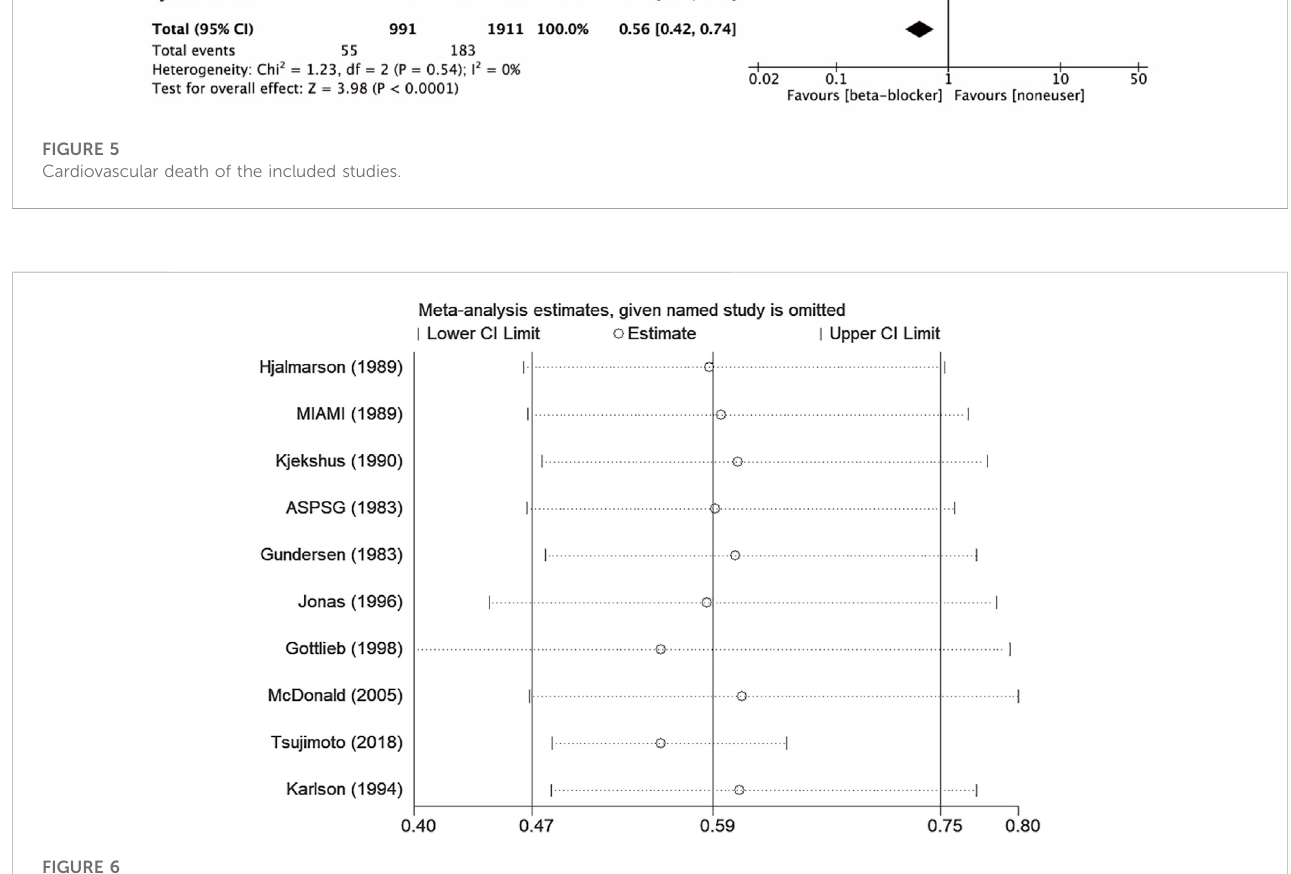
Sensitivity analysis in all-cause